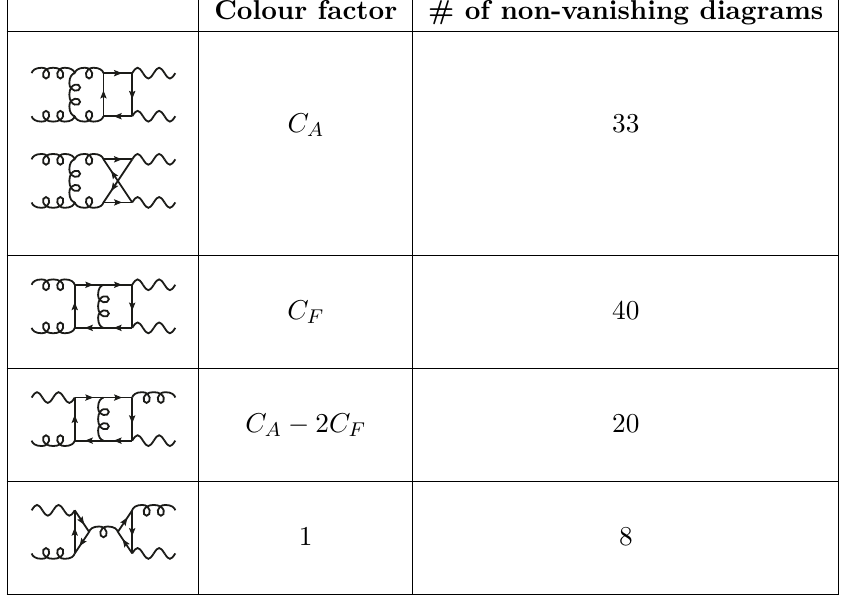
Table 1. The classification of representative diagrams by colour factors. Curly lines represent gluons, wavy lines are Z bosons and straight lines represent top quarks. All nonplanar diagrams come with colour factor C A